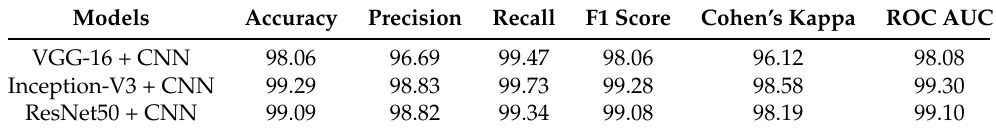
Table 5. Results of ensemble models for pneumonia